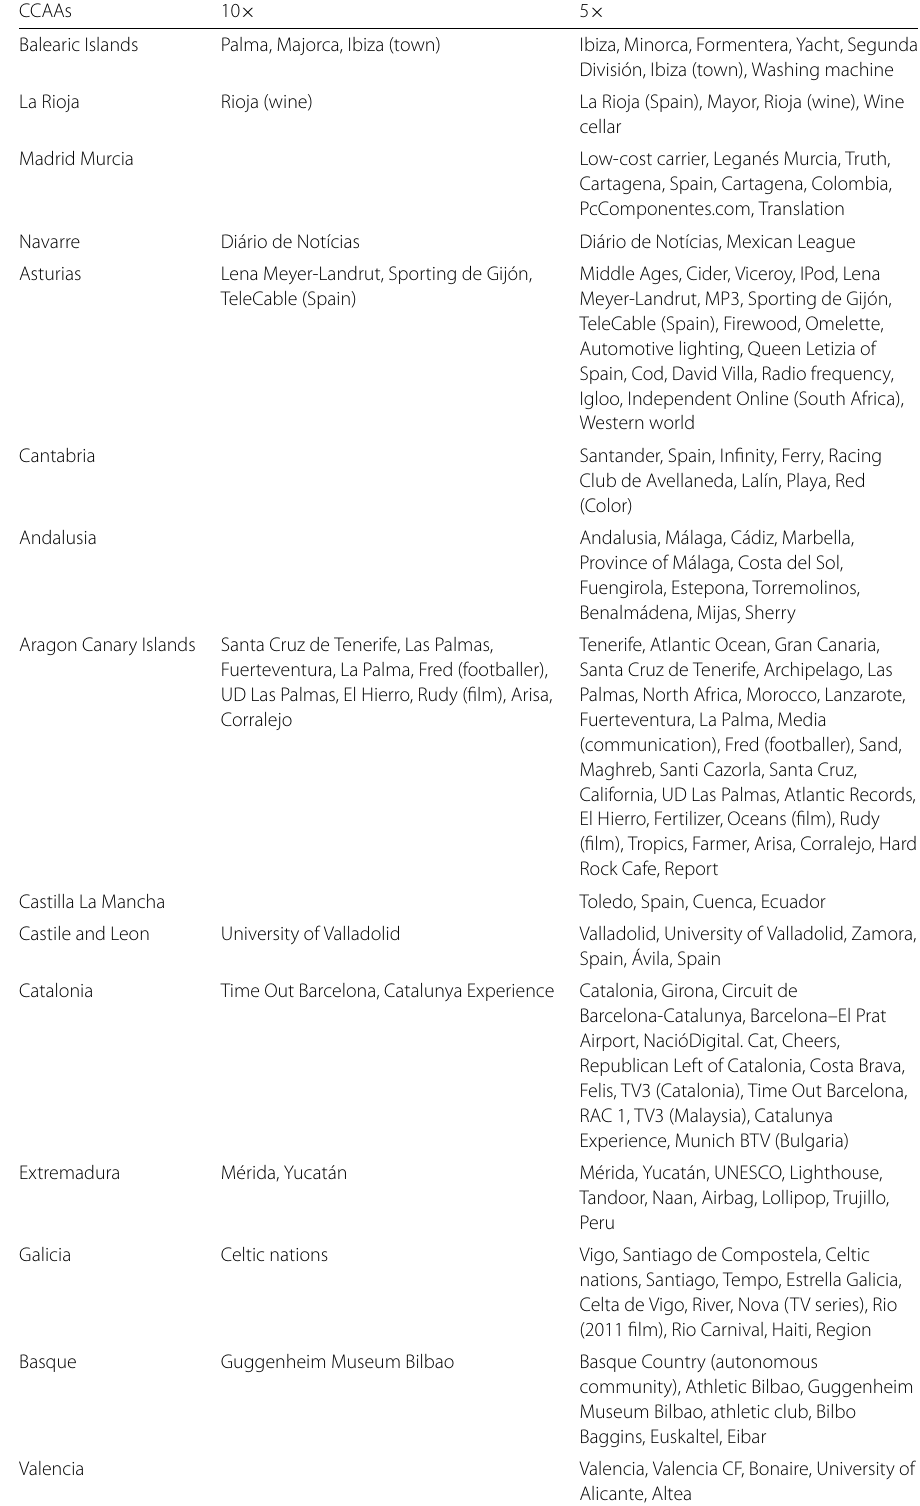
Table 5 Table of singularities for each Spanish Region